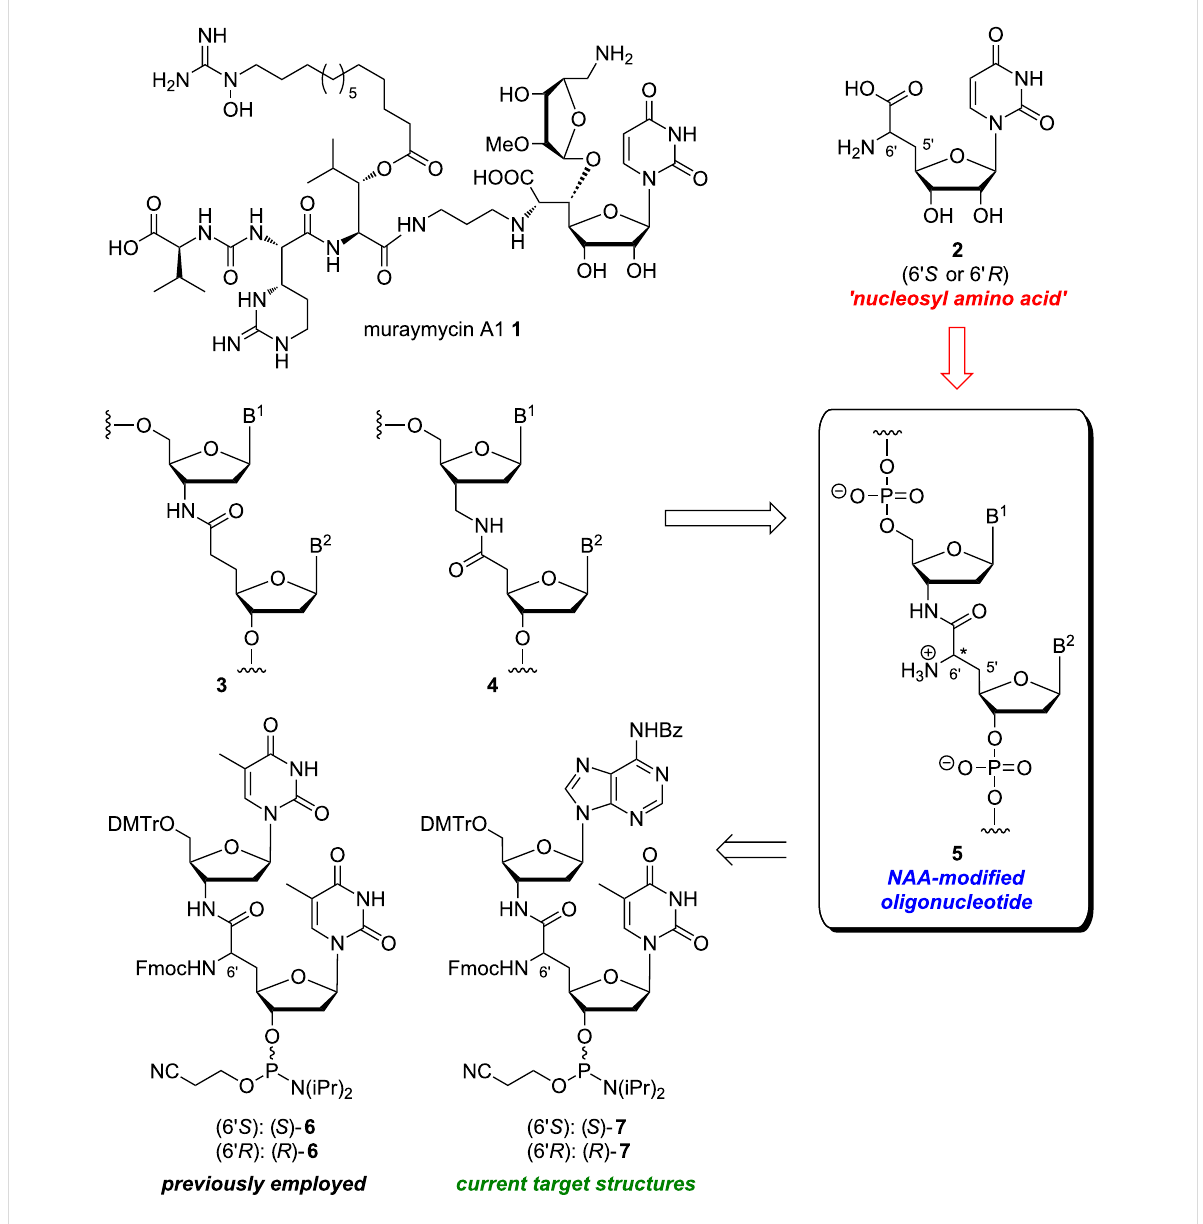
Figure 1: Design concept of nucleosyl amino acid (NAA)-modified oligonucleotides 5 formally derived from structures 1 – 4 (B 1 , B 2 = nucleobases); previously employed 'dimeric' T–T phosphoramidites 6 [38] for the automated synthesis of NAA-modified oligonucleotides; new 'dimeric' A–T phos- phoramidites 7 as target structures of this study (DMTr =